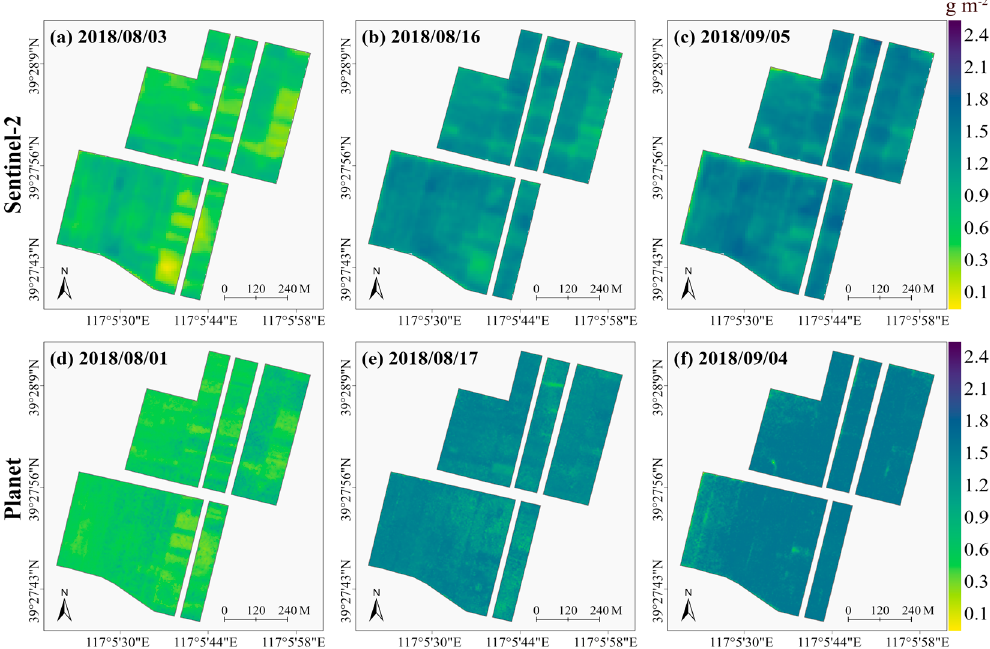
Figure 6. Multi-period maize CCC maps of Dajianchang Town obtained from ( a – c ) Sentinel-2 and ( d – f ) Planet imagery using the hybrid model.